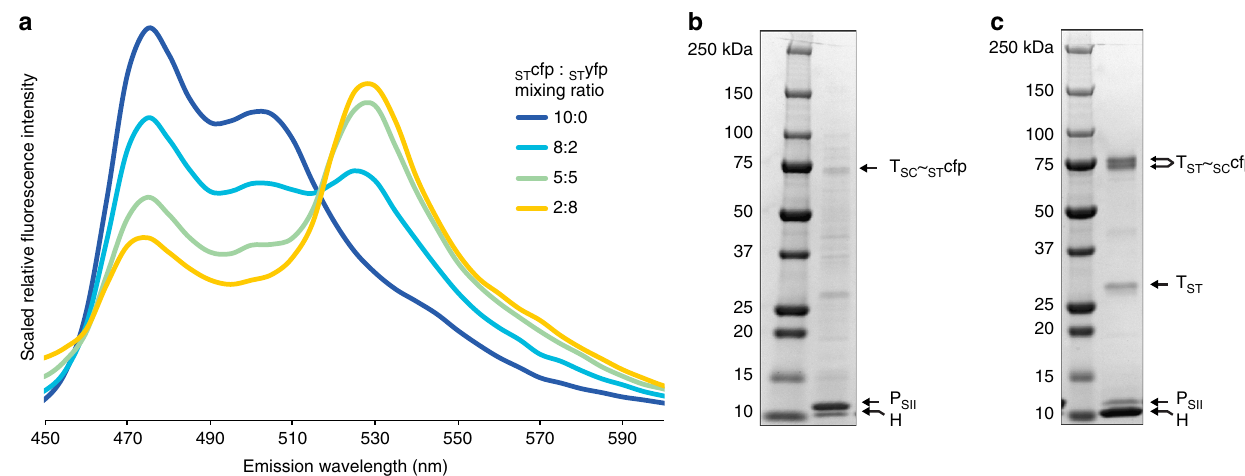
Fig. 5 Fluorescence spectra and SDS-PAGE analysis of shells containing ex vivo programmed cargo. a Scaled emission spectra (excitation: 405 nm) of programmed cargo. ST yfp-only trace (0:10) was not plotted — in the absence of a FRET donor, the fl uorescence signal is negligible. b SDS-PAGE analysis of ST cfp (10:0) programmed shells. c SDS-PAGE analysis of SC cfp programmed shells. Results are representative of two independent biological